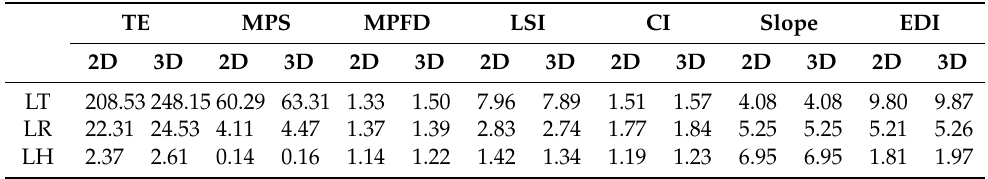
Table 6. Difference of the 2D and 3D landscape pattern